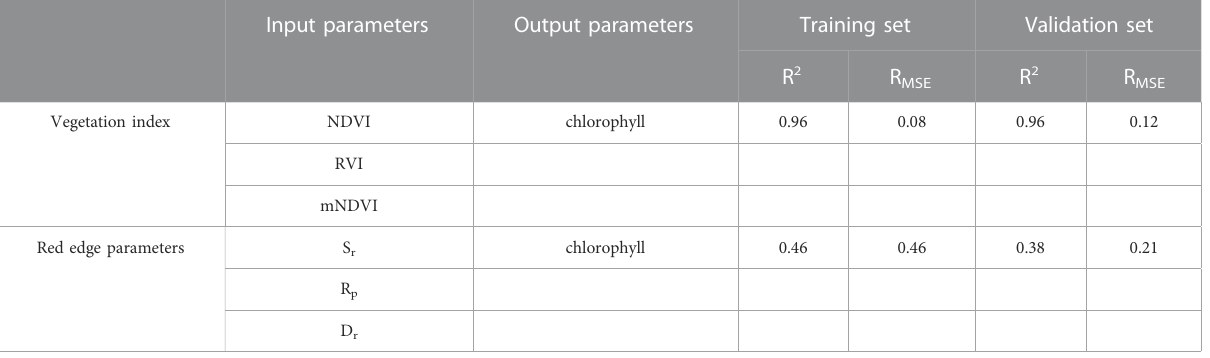
TABLE 5 BP neural network modeling parameters and